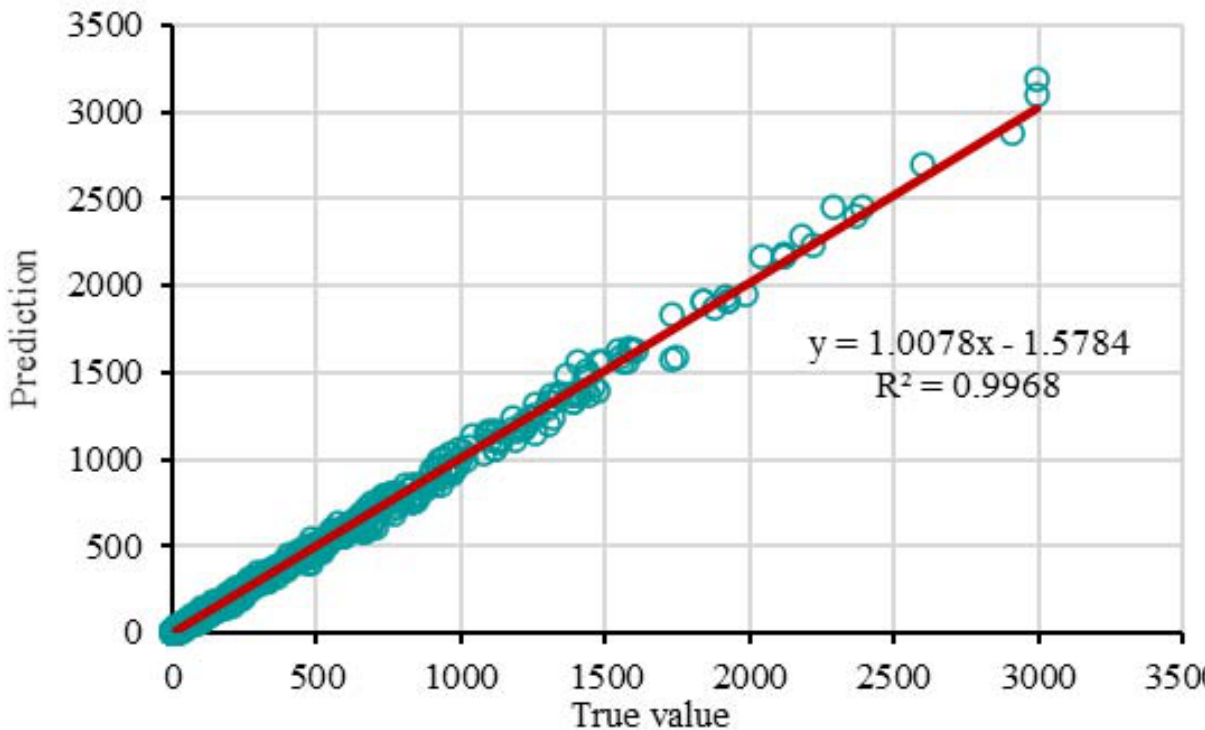
Figure 5. Regression plot for actual values and predicted values using one-hot